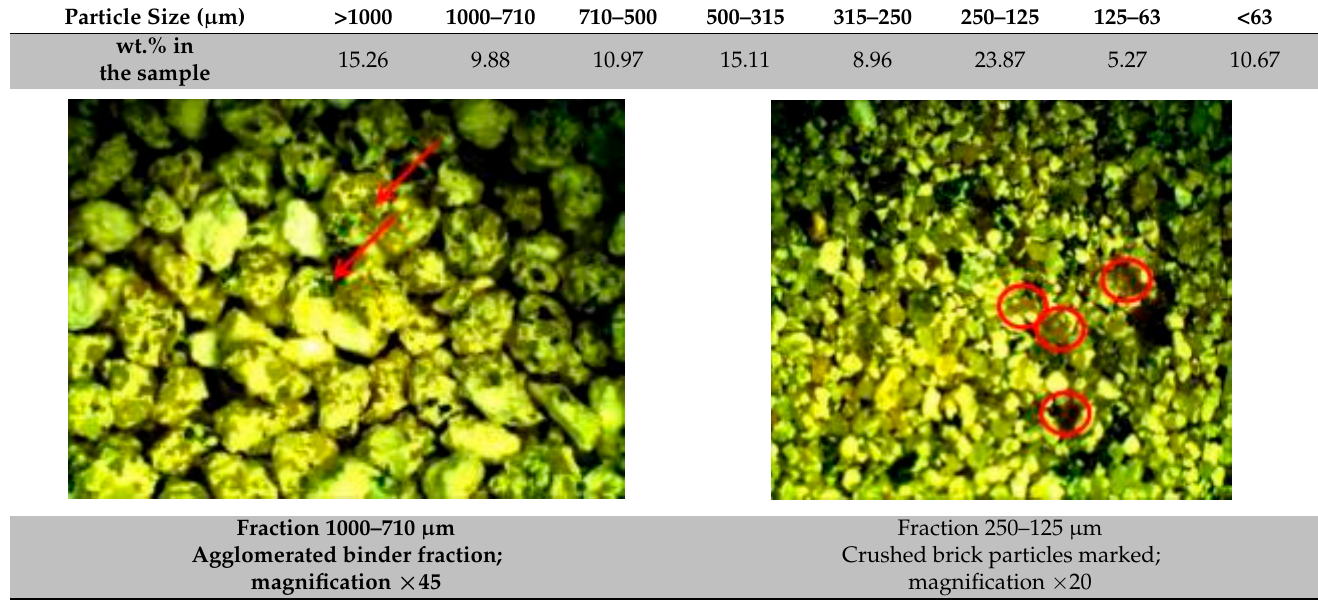
Figure 4. XRD analysis of ( a ) binder (fraction <63 µm); ( b ) agglomerated binder/lumps (fraction >710 µm); ( c ) aggregate (710–63 µm). Table 2. Sieving analysis and optical microscopy of historical mortar sample, HM. Particle Size (µm) wt.% in